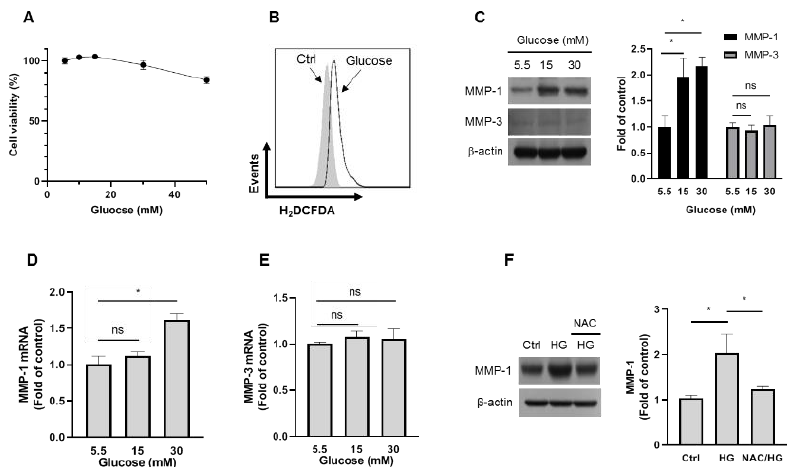
Figure 2. High glucose-upregulated MMP-1 and ROS expression in human dermal fibroblasts. ( A )